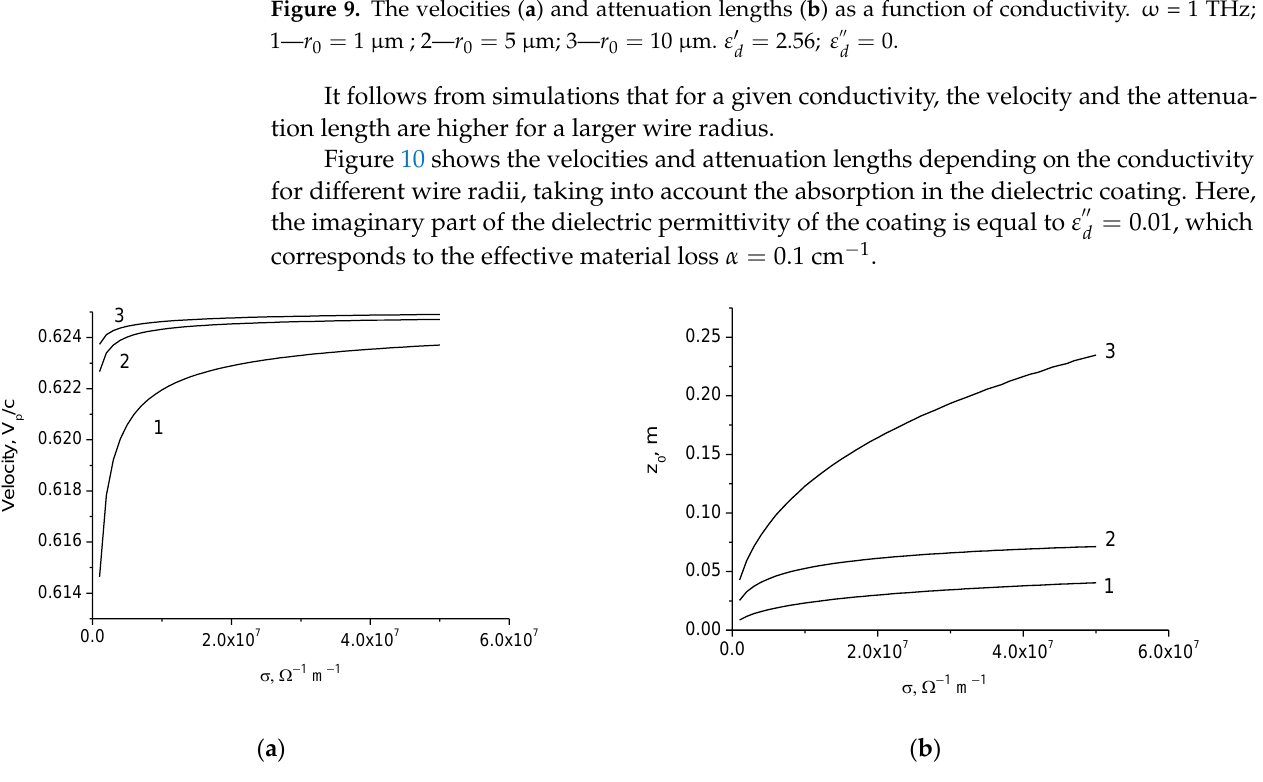
Figure 10. The velocities ( a ) and attenuation lengths ( b ) as a function of conductivity. 𝜔 = 1 THz; 1 = 2.56; ε (cid:48)(cid:48) = 0.01. 1— r 0 = 1 µ m; 2— r 0 = 5 µ m; 3— r 0 = 10 µ m. ε (cid:48) d d It follows from the simulation that absorption in a coating material has a negligible effect on the velocity of surface waves, but the attenuation lengths are significantly reduced. This indicates that the losses of the surface plasmon polariton wave in the dielectric coating are higher than in the metal wire. Currently, porous core photonic crystal fibers with a very low level of material loss have been proposed for pulse propagation [37 – 39]. These fibers have an effective material loss of less than 0.1 cm −1 at an operating frequency of f = 1 THz. In [39], a low-loss THz waveguide based on a photonic crystal structure with an average power loss of 0.02 cm −1 was designed and manufactured by 3D printing. Thus, the effect of the conductivity of metal wires on propagation characteristics of SPPs was investigated. It is shown that the phase velocity of SPPs increase with